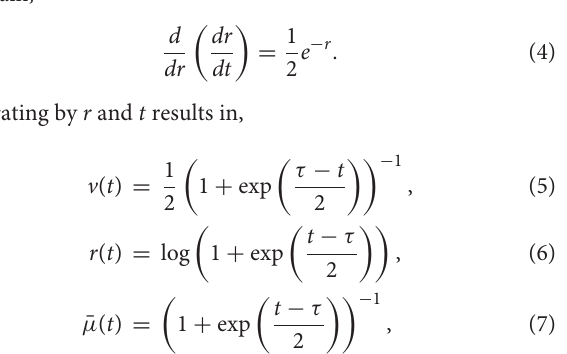
FIGURE 1 | Repressilator genetic oscillator circuit. (A) Network representation of the repressilator, in the schematic 1 represses 2, 2 represses 3, and 3 represses 1. (B) Genetic circuit diagram of a plasmid encoding the repressilator. (C) Oscillating repressor concentrations over time computed by solving Equation (11) with fixed growth rate. CDS 1, 2, and 3 are the complementary DNA sequences coding for each repressor, and Ori is the origin of